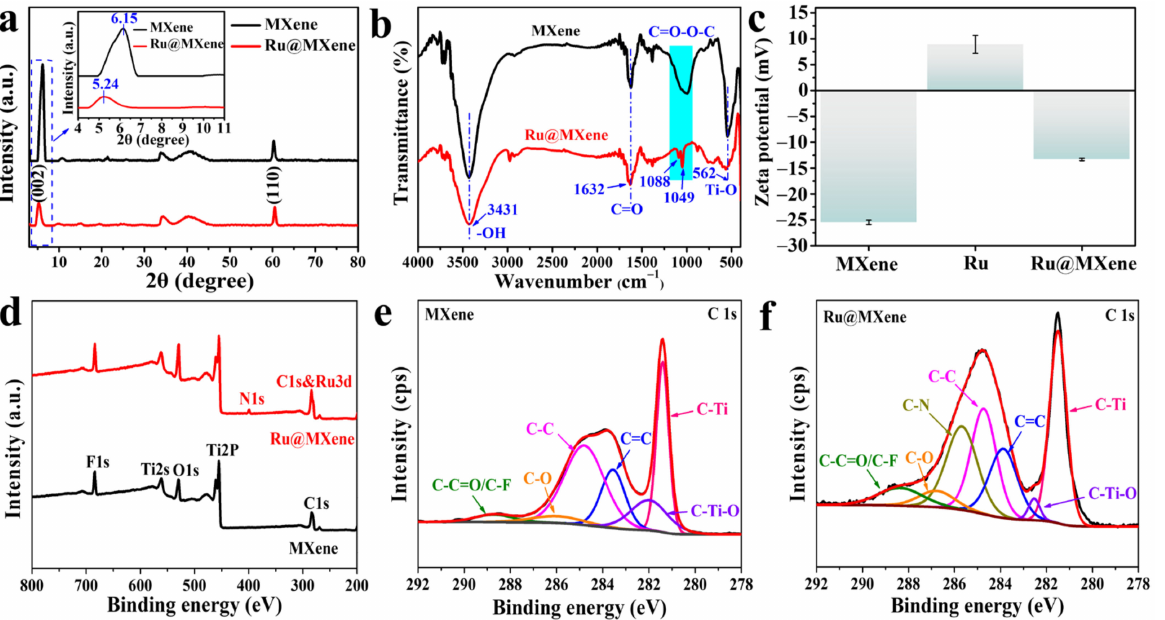
Figure 4. ( a ) XRD and ( b ) FTIR spectra of MXene and as-prepared Ru@MXene. ( c ) Zeta potential of MXene, Ru and Ru@MXene. The error bars indicate mean ± SD (n = 3). X-ray photoelectron spectra analyses of MXene and as-prepared Ru@MXene: survey scan spectrumof ( d ) both MXene and Ru@MXene; ( e ) MXene, C 1s; and ( f ) Ru@MXene, C